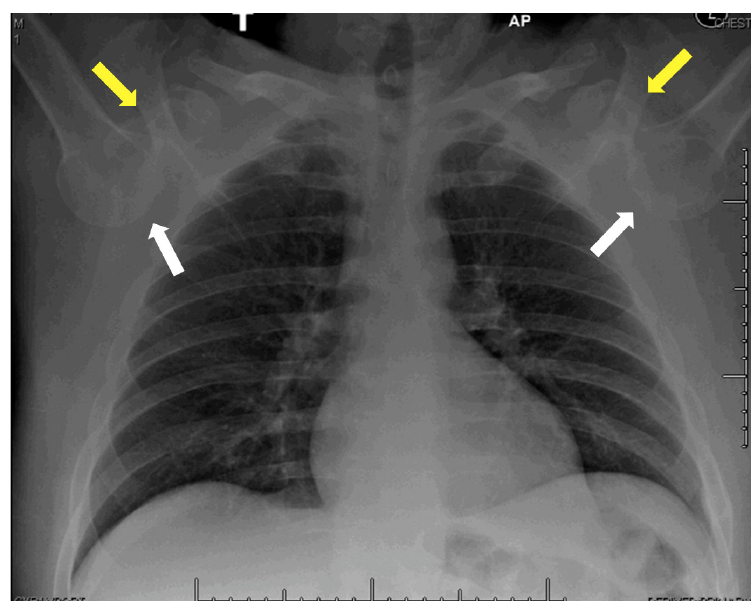
Figure. Radiograph of bilateral inferior shoulder dislocations. Humeral head (white arrow), displacement from glenoid (yellow